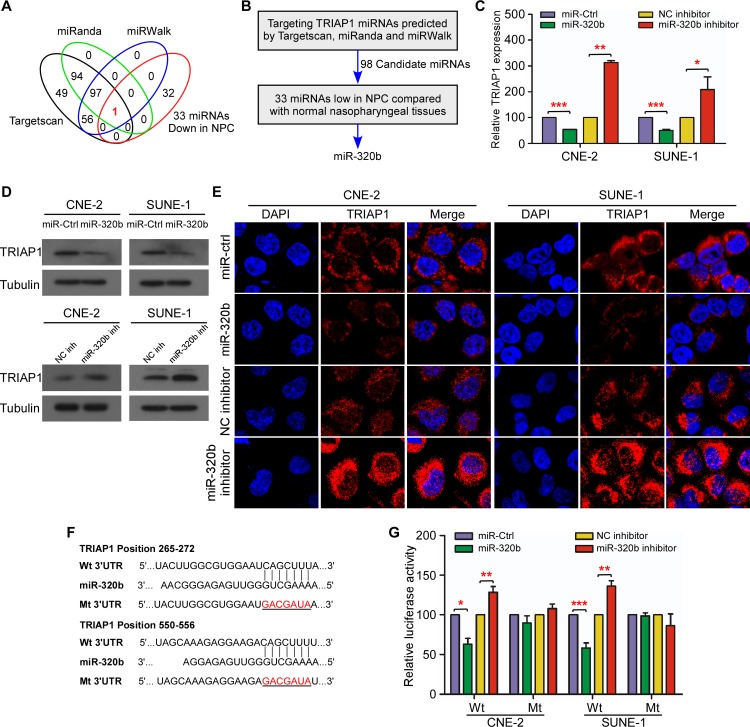
miR-320b negatively regulates TRIAP1 in NPC.(A) Schematic diagram of candidate miRNAs predicted by three different bioinformatics algorithms. Each labeled circle represents one algorithm with the number of its predicted miRNAs. (B) Outline of miRNA screening procedure. (C-E) Quantification of TRIAP1 mRNA expression by quantitative RT-PCR (C) and TRIAP1 protein expression by western blotting (D) and immunofluorescent staining (E) in CNE-2 and SUNE-1 cells after transient transfection with miR-320b mimic or miR-320b inhibitor or control. (F) Predicted miR-320b target sequence (Wild-type: Wt) or mutant sequence (Mt) in the 3′ UTR of TRIAP1. (G) Luciferase assay of CNE-2 and SUNE-1 cells after co-transfection with wild-type (Wt) or mutant (Mt) MET 3′ UTR reporter genes and miR-320b mimic miR-320b inhibitor or control. Each experiment was independently repeated at least three times. The data are presented as the mean ± s.d. Student’s t-test, ** P < 0.01, *** P < 0.001.